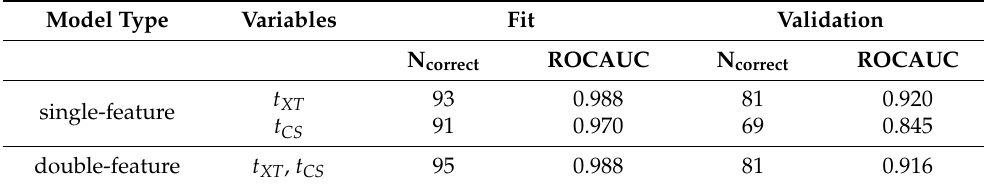
Table 2. Models built on the Franco training set and validated on the dataset collected here a .